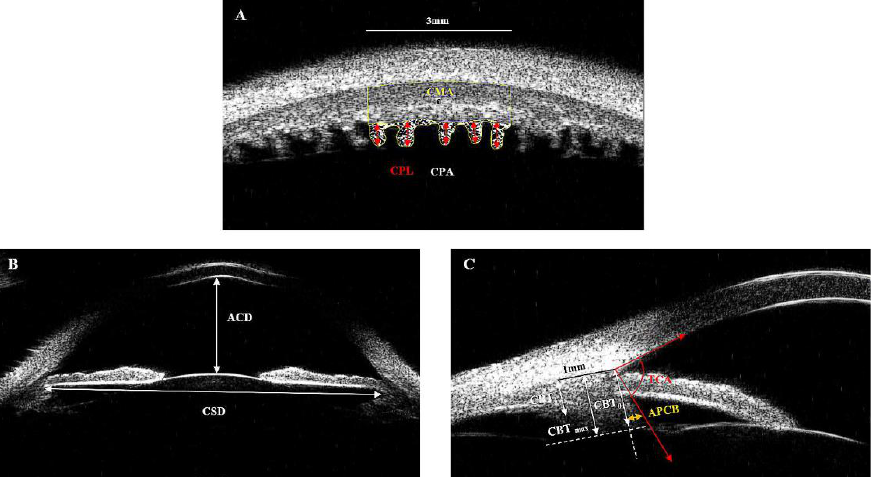
Figure 2. Measurement of ciliary parameters in UBM images. ( A ) Within the boundaries of CPs and a 3-mm linear distance, the ciliary process length (CPL) was measured by calculating the average length of each individual CP. Each individual CPL is shown by the red arrow. The CPD was defined as the number of ciliary processes. The CPA, shown as the shaded area, was measured by calculating the area of ciliary processes. The CMA, the area above the CPA, circled by yellow lines, was measured by calculating the area of the ciliary muscle. The CBA was the sum area of the CPA and the CMA. ( B ) ACD, anterior chamber depth; CSD, ciliary sulcus diameter. ( C ) CBT 0 , ciliary body thickness at the point of the scleral spur; CBT 1 , ciliary body thickness at a distance of 1 mm from the scleral spur; CBT max , maximum ciliary body thickness; APCB, anterior placement of the ciliary body; TCA, trabecular-ciliary angle.